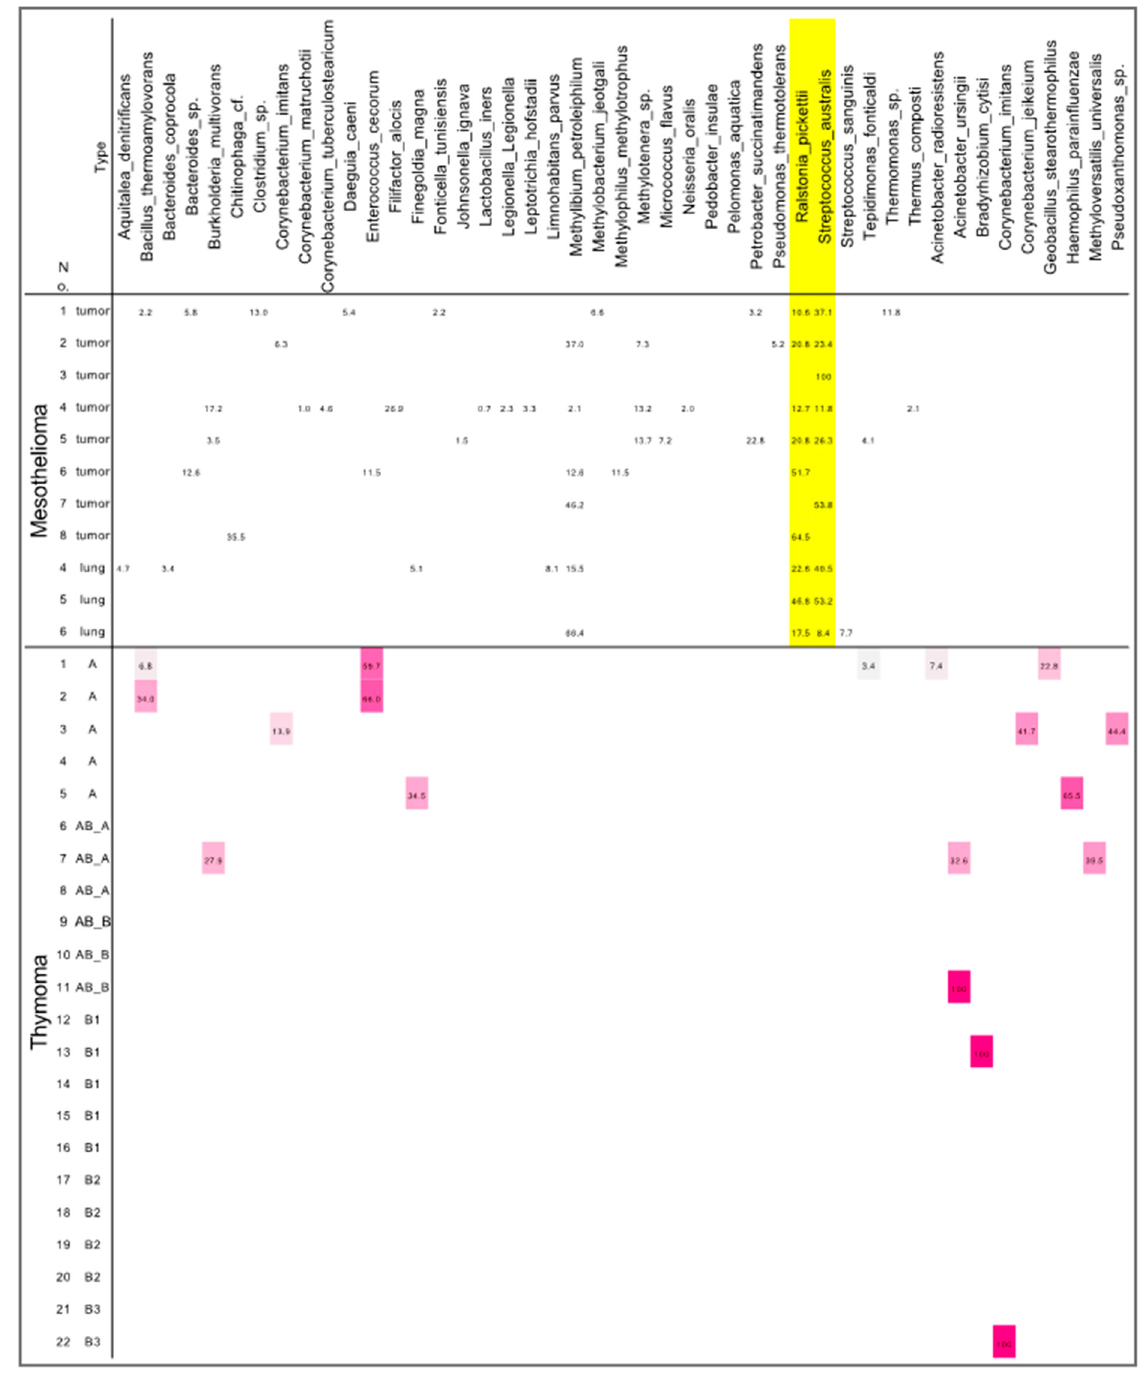
Figure 2. Microbiome differences between mesotheliomas and thymomas. Streptococcus australis and Ralstonia pickettii in the mesotheliomas are highlighted in yellow.